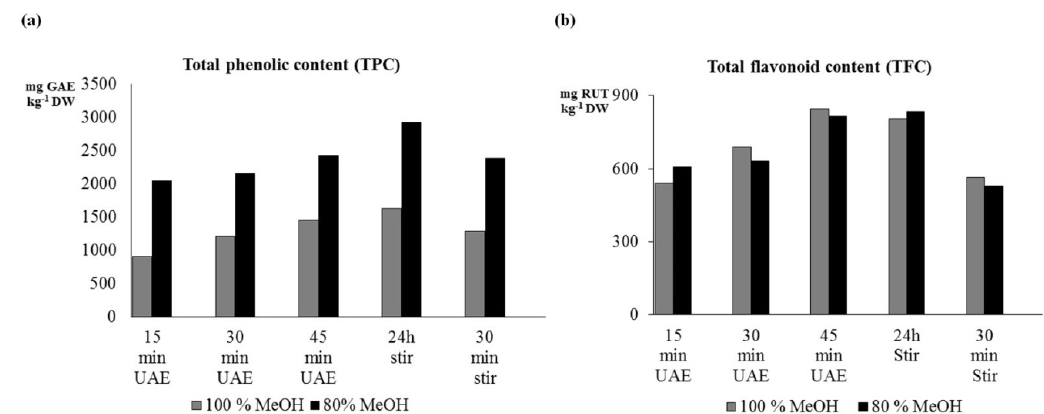
Fig. 1: Effect of the extraction solvent and extraction time on the TPC (a) and on the TFC (b) in Coriandrum sativum L.